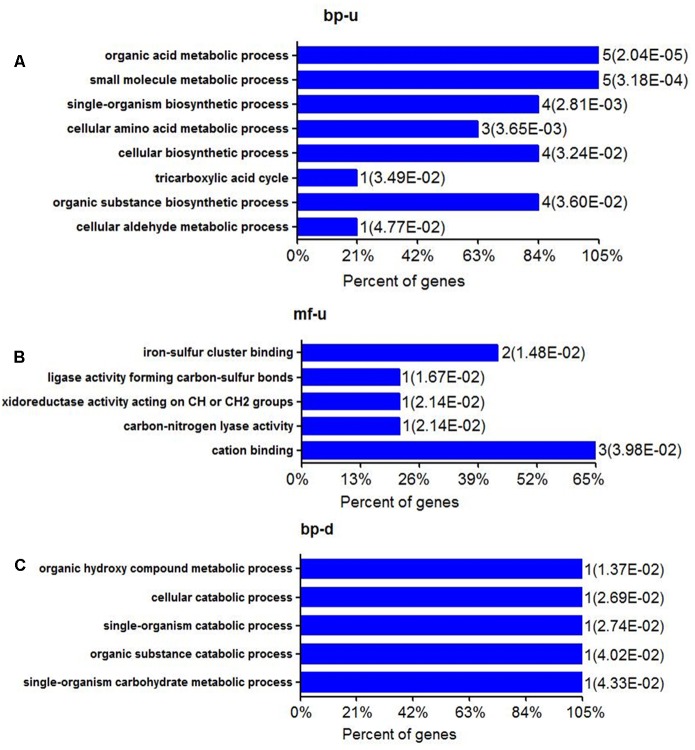
Biological processes and molecular function of differential expressed proteins of E. tarda in alanine treatment at the protein level. (A,B) Gene ontology (GO) shows up-regulation of biological processes and molecular functions (C) GO of BP in down-regulated proteins. MF can’t be enriched.